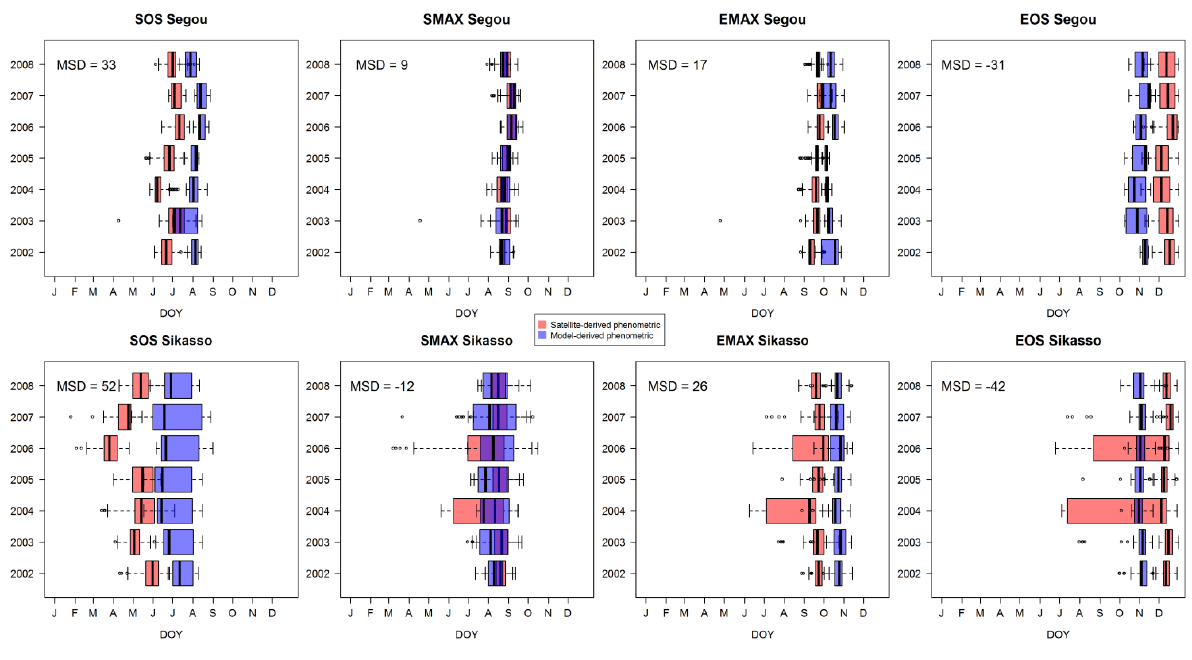
Figure 7. Satellite- (pink) and model-derived phenometrics boxplots (violet) calculated for Segou and Sikasso from 2002 to 2008. The mean signed difference (MSD) corresponds to the difference in days between the model- and satellite-derived